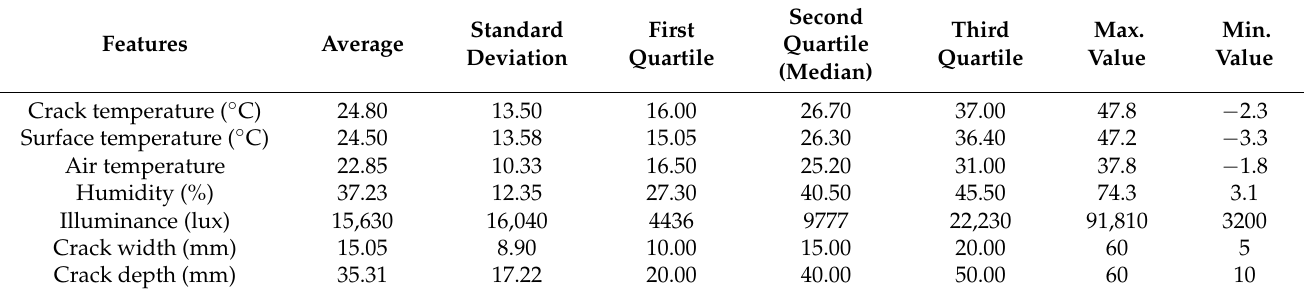
Table 4. Statistical